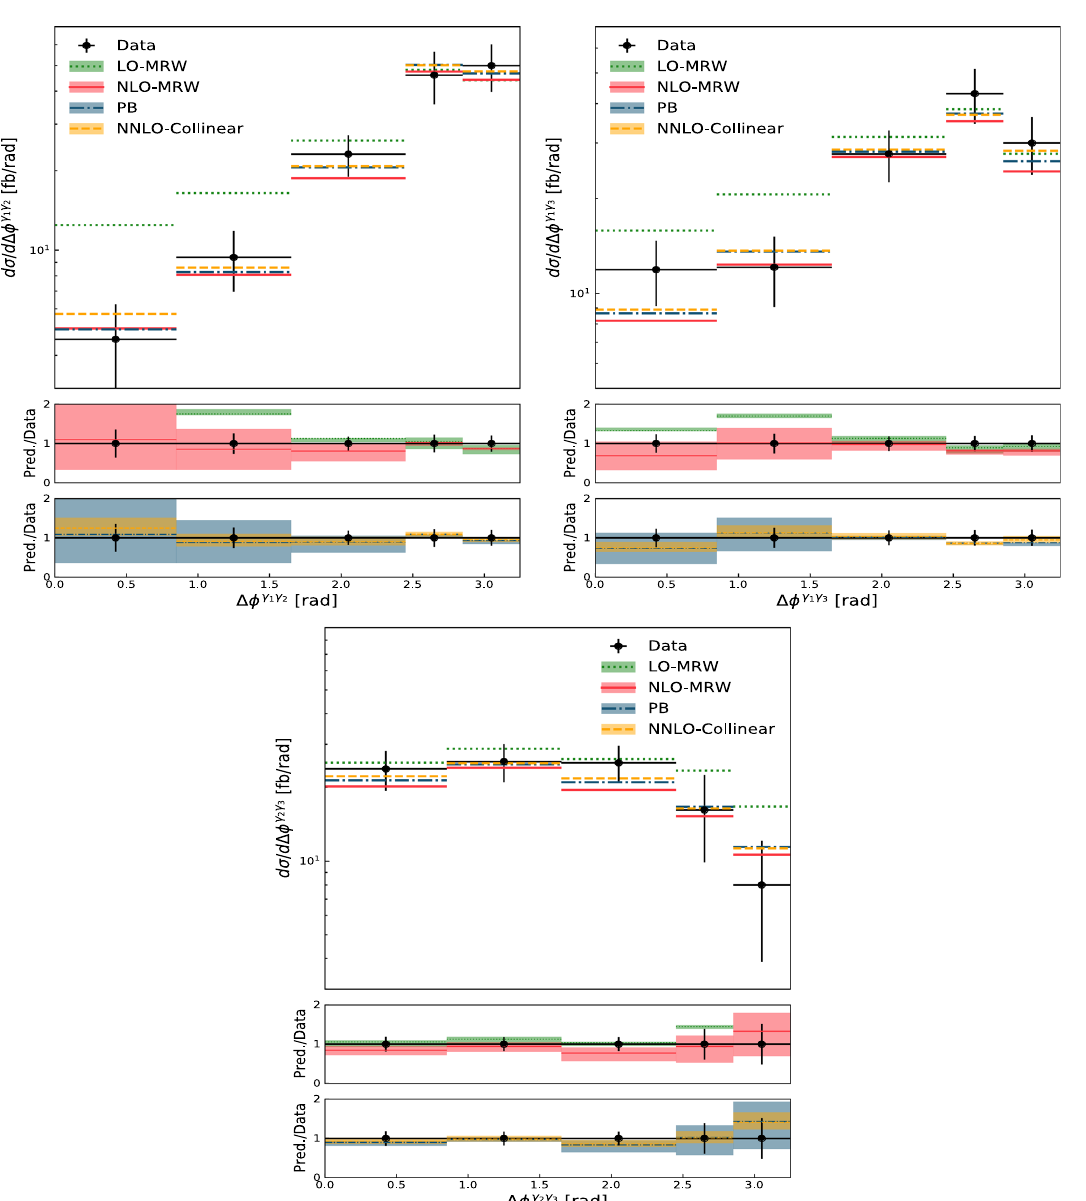
Fig. 7 The same as Fig. 6 but for difference between azimuthal angles of final state photons, and also no comparison between sub-processes is